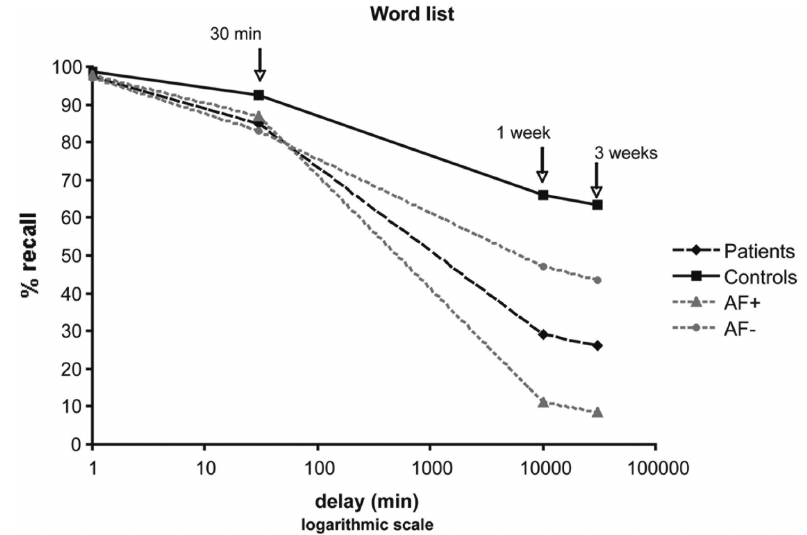
Fig. 1. Accelerated long-term forgetting in a group of 24 patients with TEA, 12 of whom complained speci fi cally of accelerated long-term forgetting (AF + ), whereas 12 did not (AF − ). tients with TEA show normal learning of a word